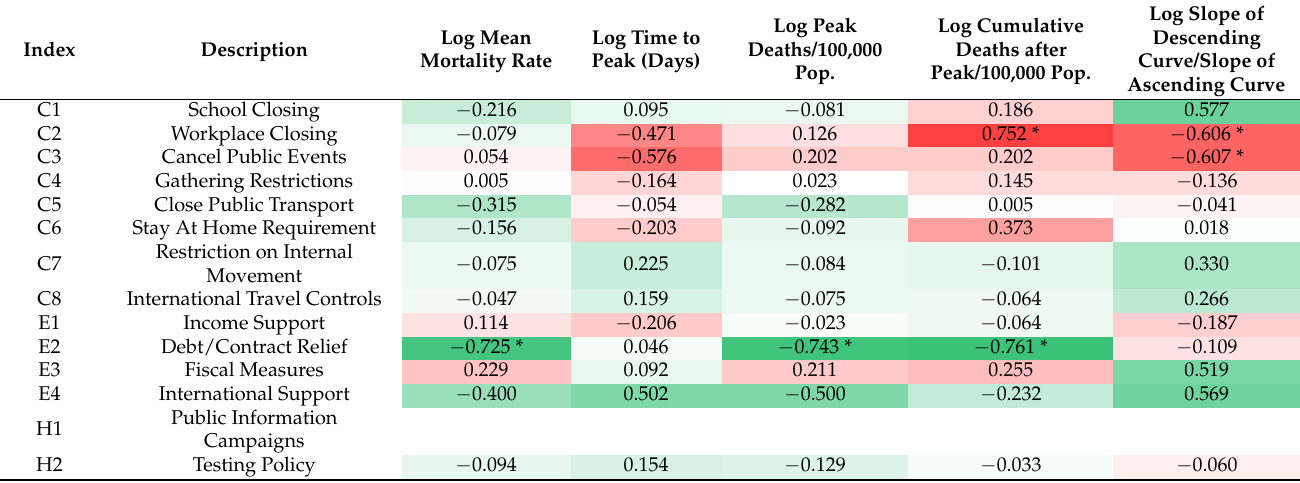
measures of pandemic severity in the old population based on median country age.